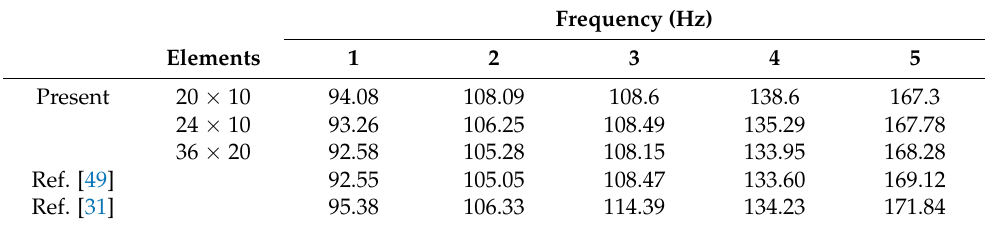
Table 1. Comparison of the lowest natural frequencies of clamped-free isotropic cylindrical